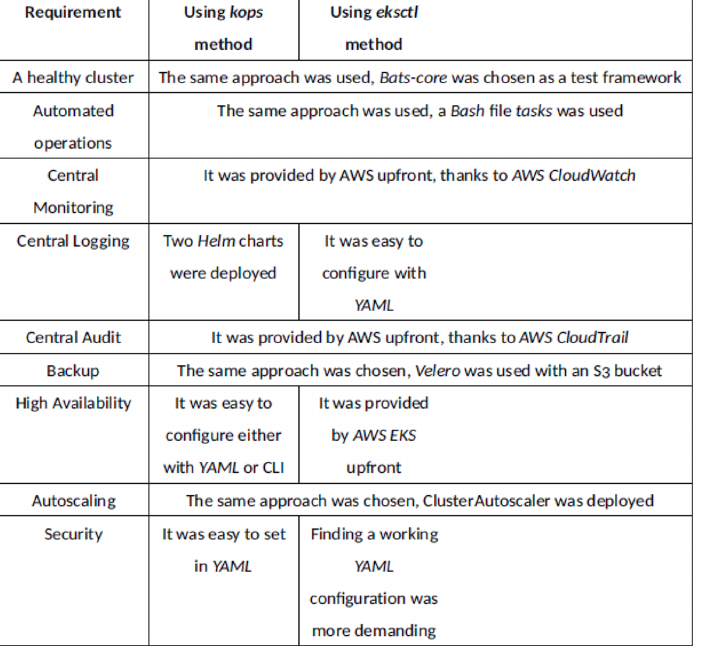
Table 2. Files used to deploy minimal and full clusters using: kops and eksctl